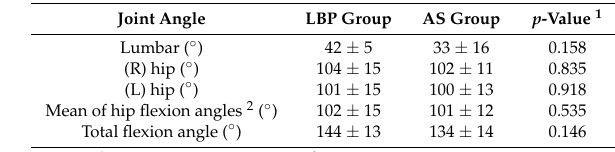
Table 2. Lumbar spine, hip joint angles in simulated deep squatting position.